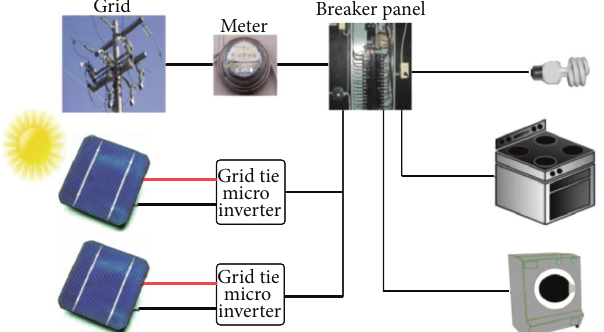
Figure 1: A diagram of the power system using electrical grid and solar